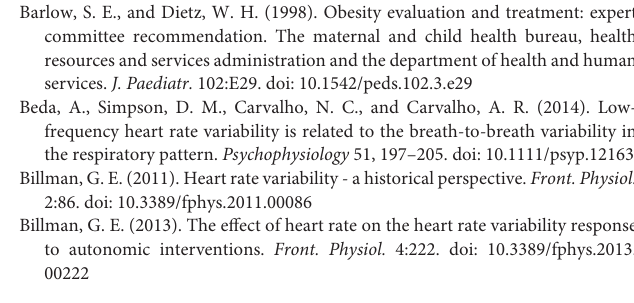
Table S11 , Sheet “Corrected HRV Calculator”) and simplifies determination of HRV parameters from an individual child and if values are within normal